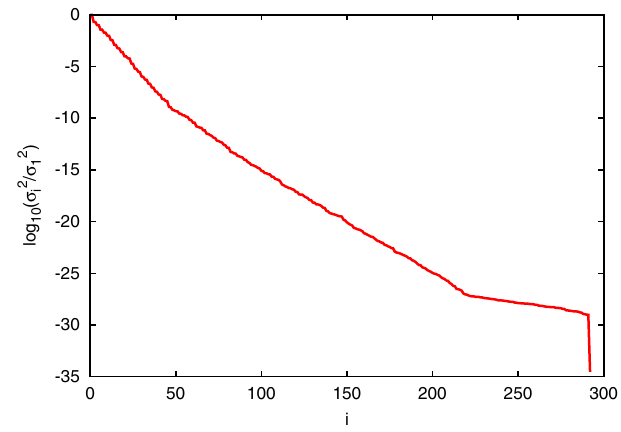
relative to (cid:1) 2 . cs 1